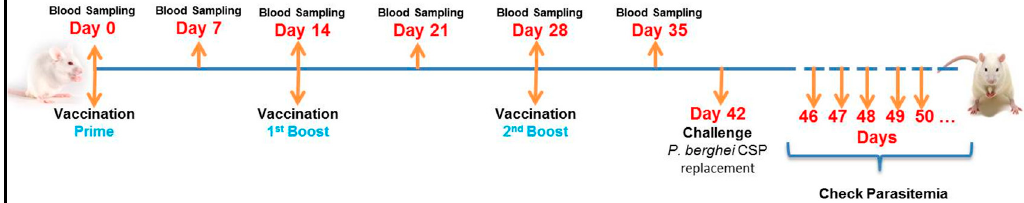
Figure 3. Experimental Design. BALB/c mice were vaccinated intramuscularly with 7.5 μ g of CSP for each dose (50 μ L). The vaccinations were done 3 times: prime (Day 0), first boost (Day 14) and second boost (Day 28). The samples (sera) were collected weekly, starting before the first vaccination (Day 0) and up to Day 35 (one week before the challenge). On day 42 the mice were challenged with P. berghei expressing CSP of P. vivax . As described before, the parasitemia was checked daily beginning in the 4th day after challenge until the mice get 1% parasitaemia, when they were euthanized.